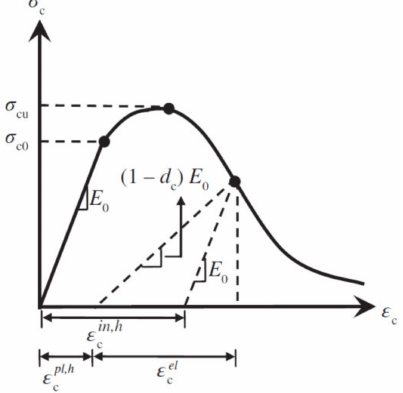
Figure 2. Concrete response to uniaxial compressive loading